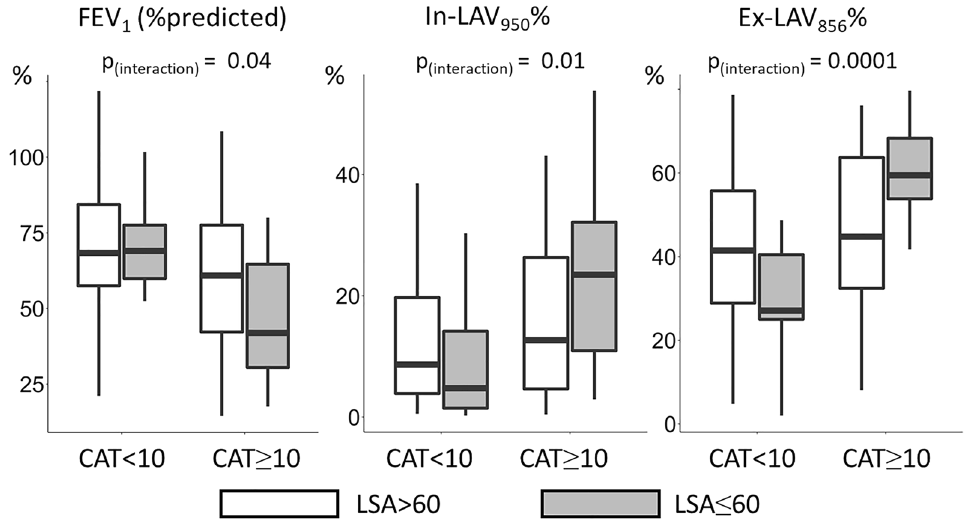
Figure 2. Airflow limitation, emphysema and air-trapping in subgroups defined based on symptoms and physical activity. Based on scores of COPD assessment test (CAT) and Life-Space Assessment (LSA), patients with COPD were classified into 4 groups. There were significant interactions between CAT and LSA on FEV 1 , In-LAV 950 %, and Ex-LAV 856 % ( p = 0.04, 0.01 and 0.0001, respectively).